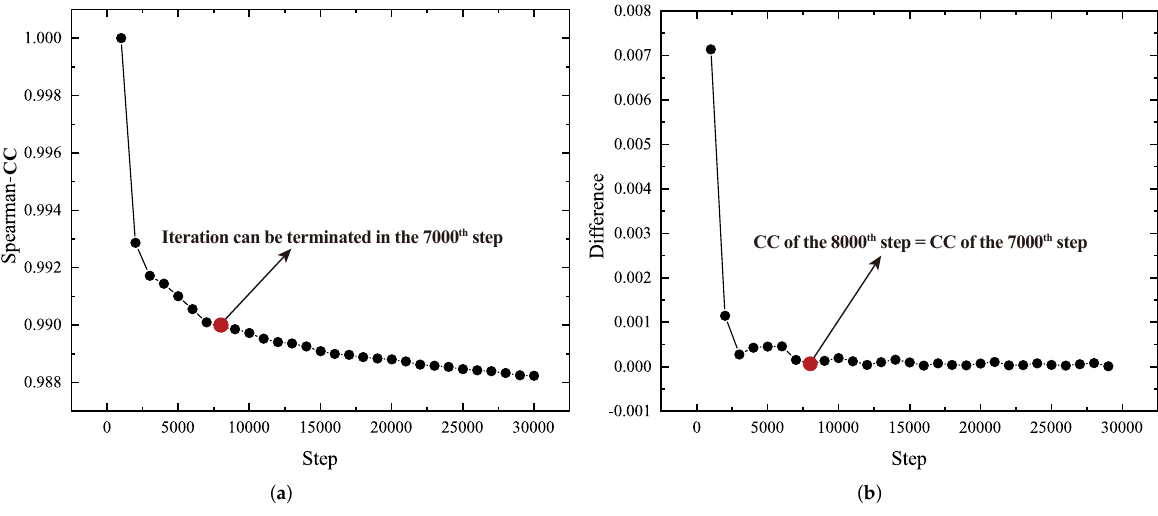
Figure 4. The statistical results of a simple illustration. ( a ) The relationship between the Spearman-CC and step, ( b ) the relationship between inter-step difference and